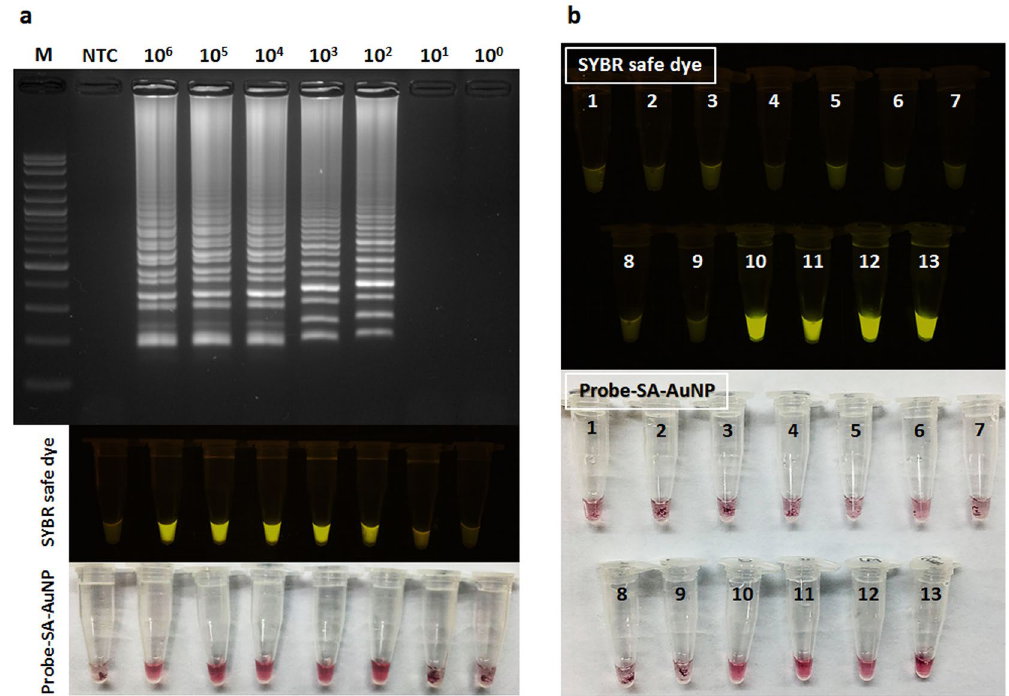
Figure 5. Sensitivity and specificity of one-step SYBR safe and AuNP-LAMP assay, ( a ) LOD of the assay under gel electrophoresis, fluorescent and color visualization (ten fold serial dilution; 10 6 –10 0 parasites/mL): 100 bp ladder (M), no template control (NTC), ( b ) LAMP detection of different pathogens’ DNA based on SYBR safe dye and probe-SA-AuNP: tube 1; nuclease-free water, tube 2; human genomic DNA, tubes 3–13; E. coli , G. intestinalis , T. vaginalis , P. falciparum , N. gonorrhea , S. pyogenes , S. flexneri , T. evansi , L. donovani , L. martiniquensis and L. siamensis ,